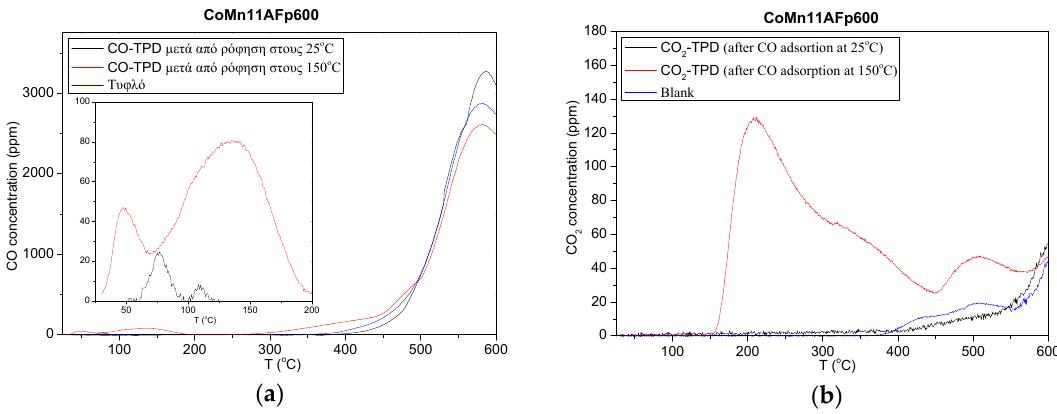
Figure 1. TPD following CO adsorption at 25 °C or 150 °C on CoMn11AFp600 catalyst: ( a ) CO desorption; and ( b ) CO 2 desorption.